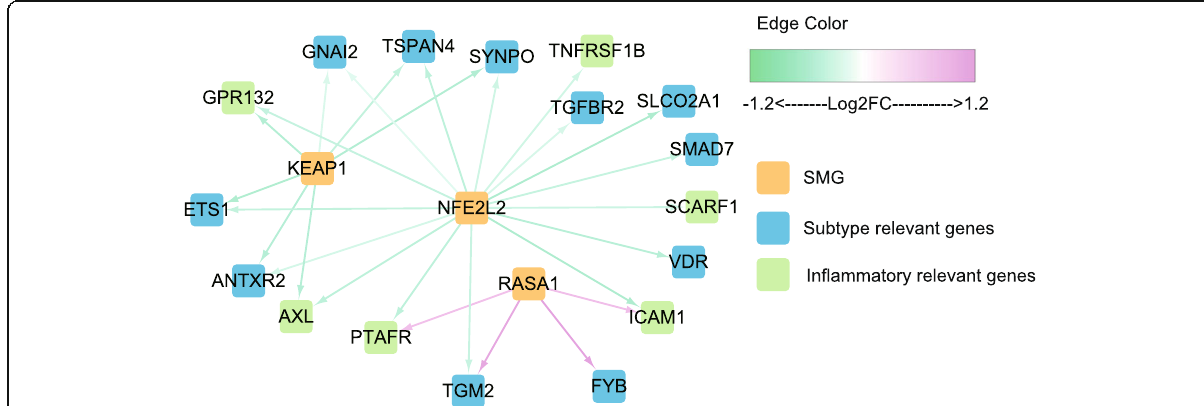
Fig. 6 A core association network between SMG and down-stream elements. Yellow nodes are SMGs, the other nodes are genes showing the top-50 important scores in separating the two subtypes for LUSC, and the inflammatory relevant ones are marked by green. Edges stand for the significant associations (T-test, un-paired, two-sided, FDR adjusted P -value < 0.05), and edge colors represent the log2 transformed fold change (log2FC) values of down-stream genes in mRNA level between samples with and without mutations in the